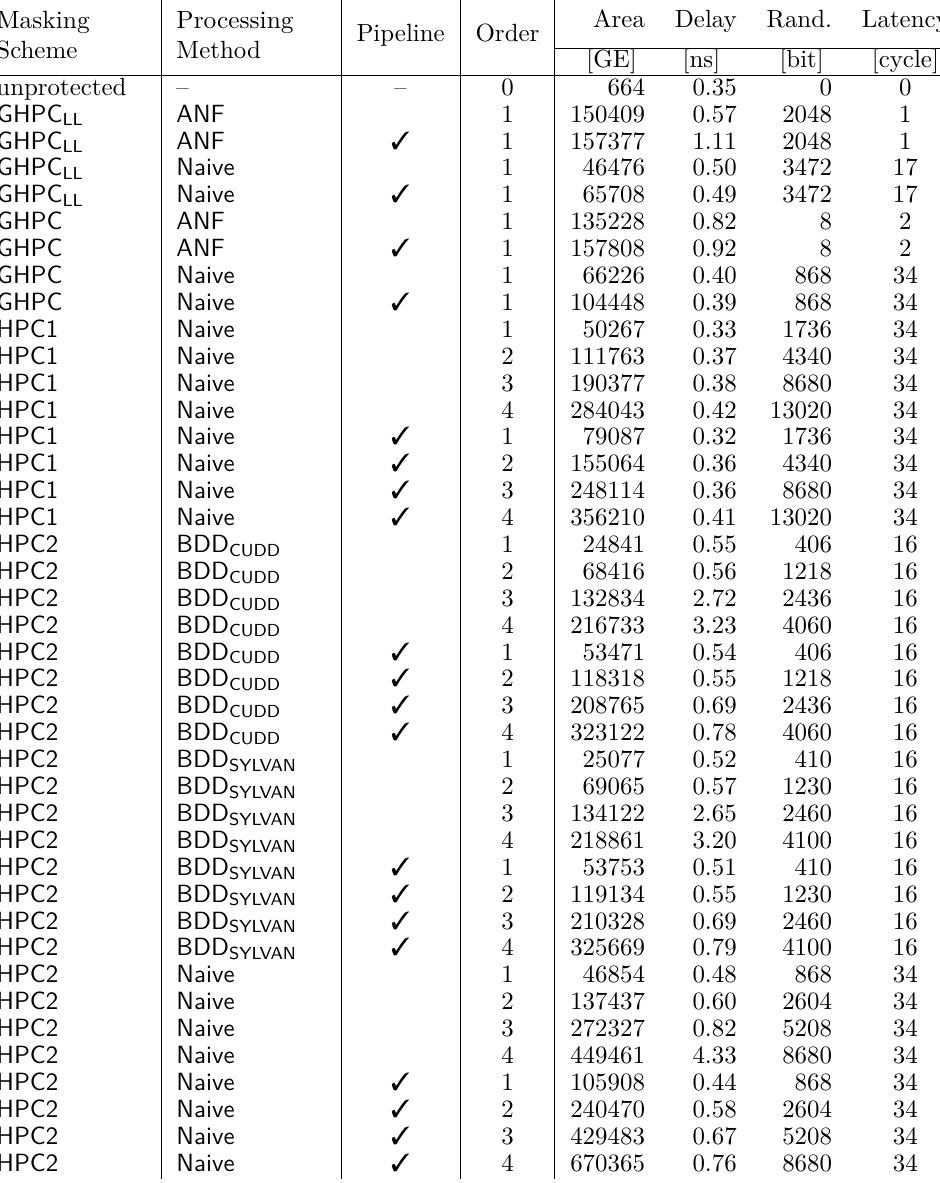
Table 5: Synthesis results, AES S-box lookup-table